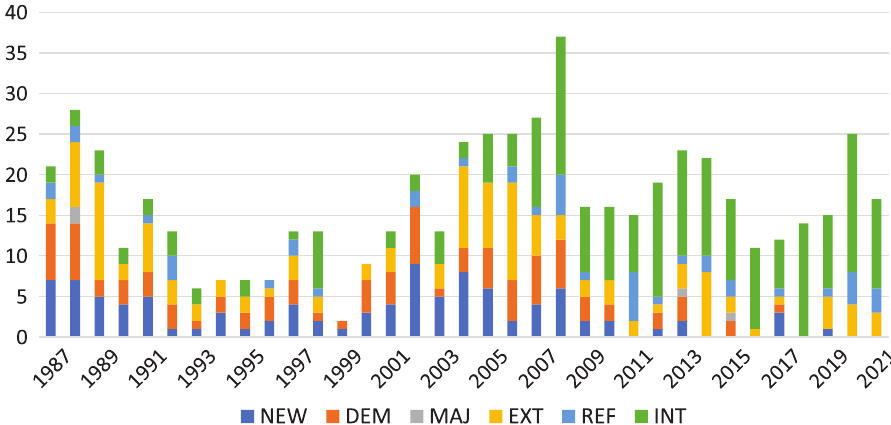
Figure 4. Trends in major development type between 1987–2021 in the HCCA. Note: Categories used refer to those out‐ lined in Section